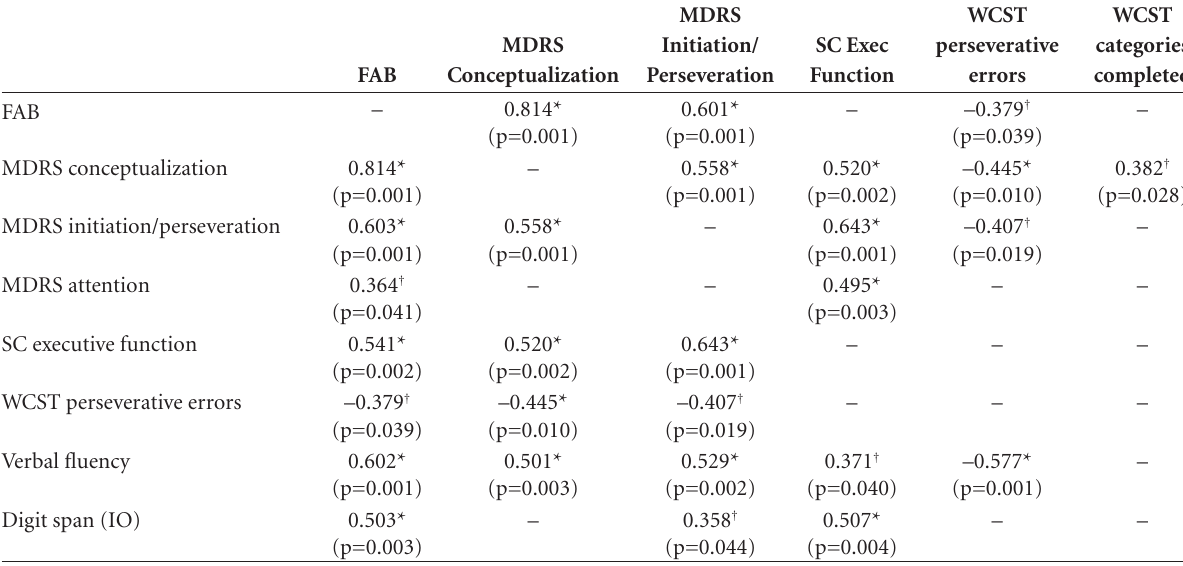
Table 2. Correlations between cognitive tests (Spearman correlation coefficient (r